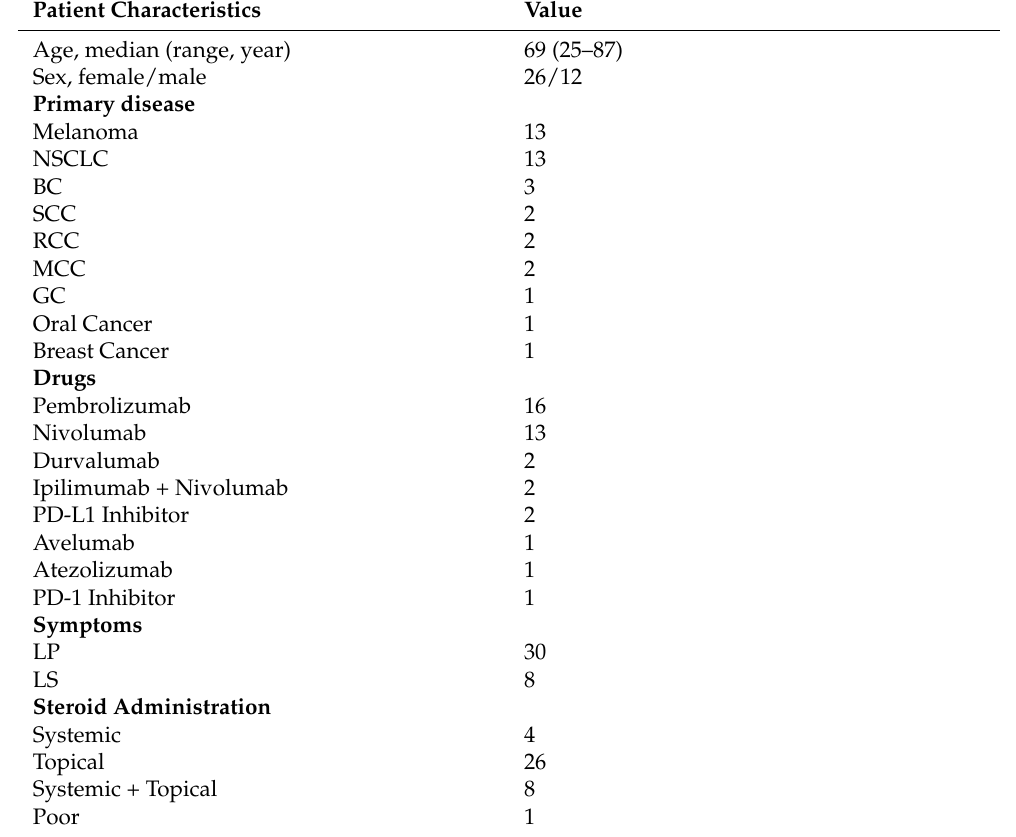
Table 2. Demographic characteristics of patients with immune-checkpoint-inhibitor-related lichen sclerosus and lichen planus reported in the